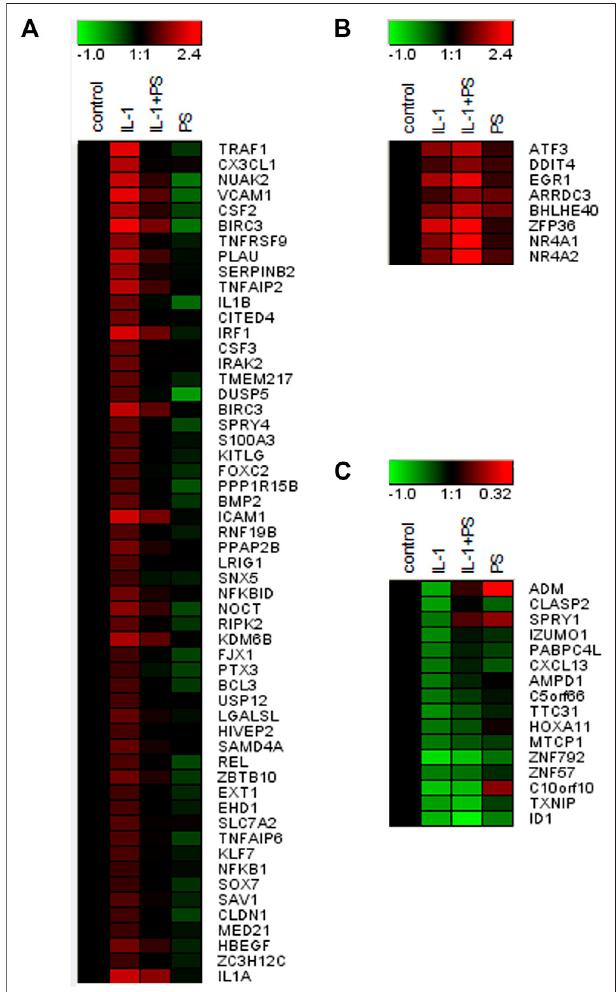
FIGURE3| Geneexpressionpro fi leofPS+IL-1vs.IL-1treatedHUVEC. A heat map of genes (Of fi cial Gene Symbols; gene names are given in Supplementary Table S3 ) that are regulated more than 3-fold by PS + IL-1 as compared to IL-1 alone is shown. Cells were pre-treated with 50 μ g/ ml PS for 30 min and then stimulated for 2 h with 5 ng/ml IL-1. (A) up- regulation by IL-1, down-regulation by PS; (B) up-regulation by IL-1 and further up by PS; (C) down-regulation by IL-1, further regulation by PS (up or down). Colors indicate up-regulation (red) and down-regulation (green), logarithmic scale. Note that the scale was adjusted between (A) , (B) , and (C) for optimal